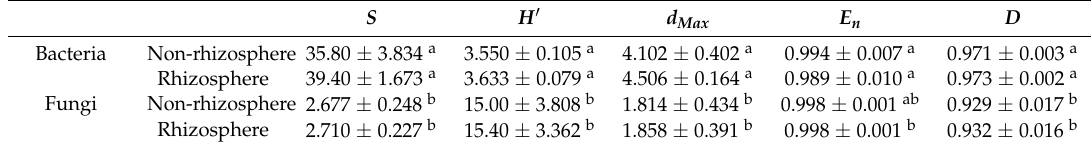
Table 1. Mean (±SD) diversity indices of microbial community in rhizosphere and non-rhizophere soil. S H' d Max E n D Bacteria